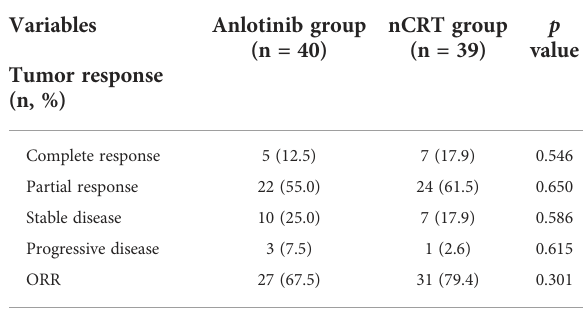
TABLE 4 Tumor response of the two groups. TABLE 3 Pathologic outcomes of the two